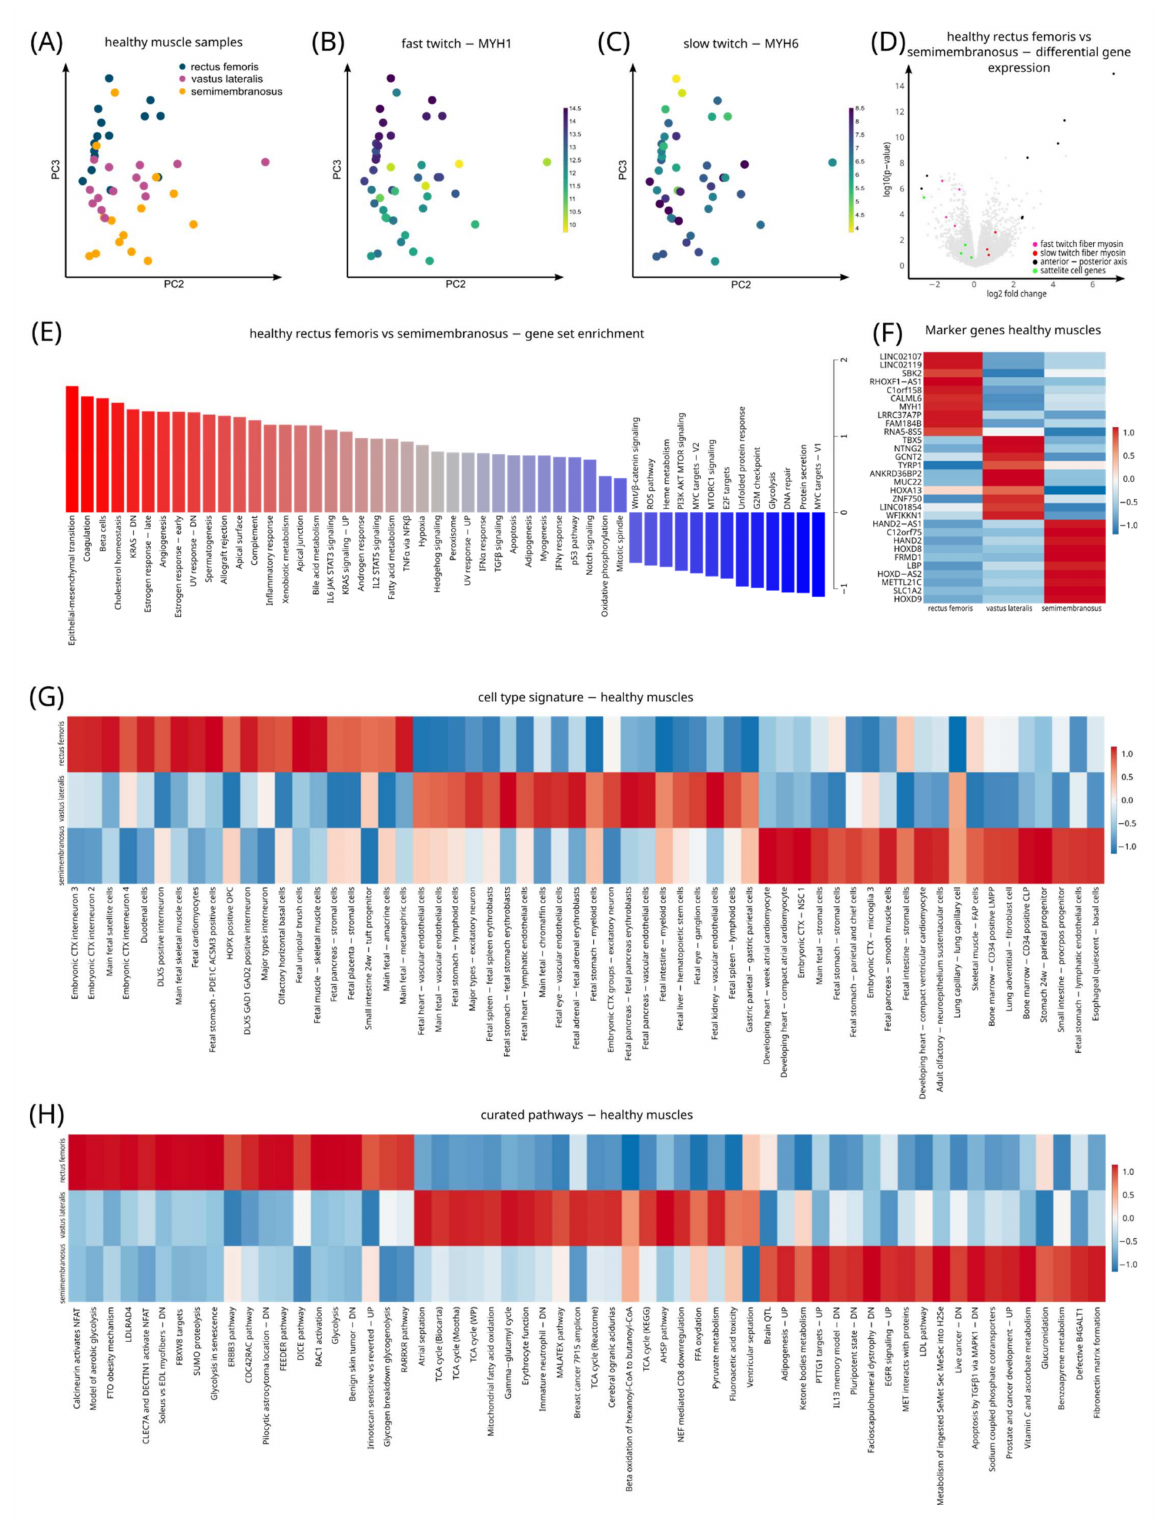
Figure 4. Gene signatures across muscles in healthy control muscles. ( A ) PCA of healthy control samples color coded for muscle of origin. ( B ) PCA of healthy control samples color coded for MYH1 gene expression, which is characteristic for fast-twitch muscle fibers. Note the highest expression of MYH1 in the rectus femoris muscle. ( C ) PCA of healthy control samples color coded for MYH6 gene expression, which is characteristic for slow-twitch muscle fibers. Note the highest expression of MYH6 in the semimembranosus muscle. ( D ) Volcano plot of a differential gene expression analysis